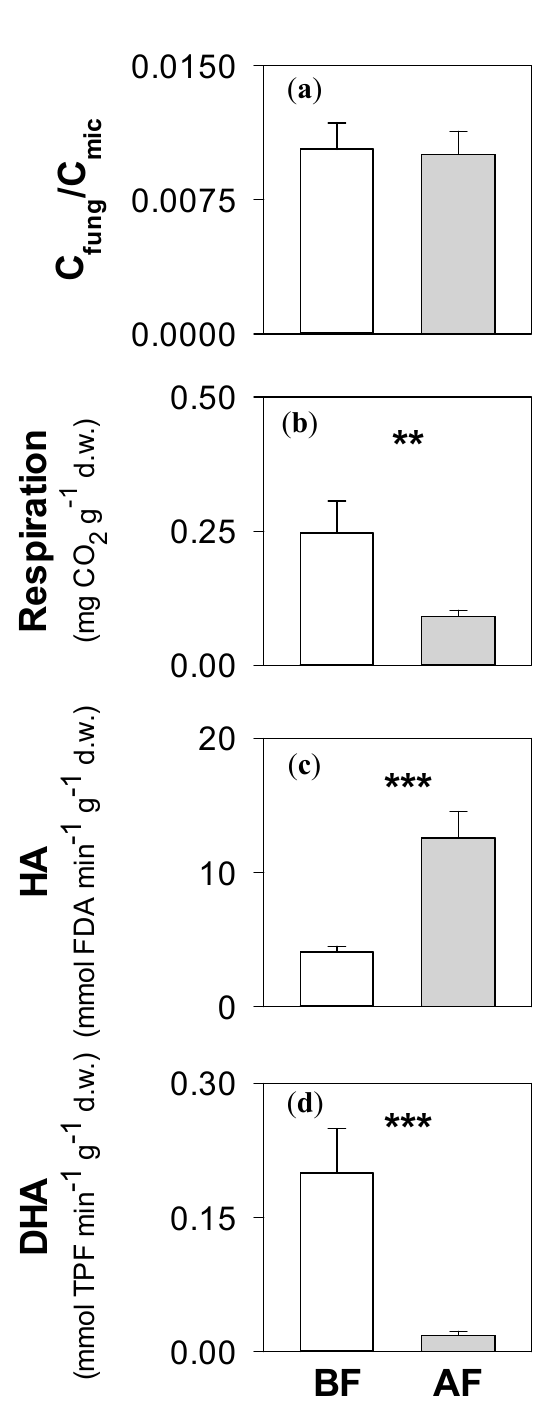
Figure 2. Mean values ( ± e.s.) of ( a ) C fung / C mic , ( b ) microbial respiration, ( c ) hydrolase activity (HA), ( d ) dehydrogenase activity (DHA) measured before (BF) and after fire (AF) in soils collected on the Vesuvius National Park, Southern Italy. The asterisks indicate significant differences ( t -test—*: p < 0.05, **: p < 0.01, ***: p < 0.001) in soil properties between BF and AF soils. The multiple regressions highlighted that soil biological properties are impacted more by available fractions of elements than by soil pH, water content, total C and N contents and organic matter content. In particular, the F1, F2 and F3 fractions of Al, Cr and Cu a ff ected all the investigated soil biological properties in both BF and AF soils (Table